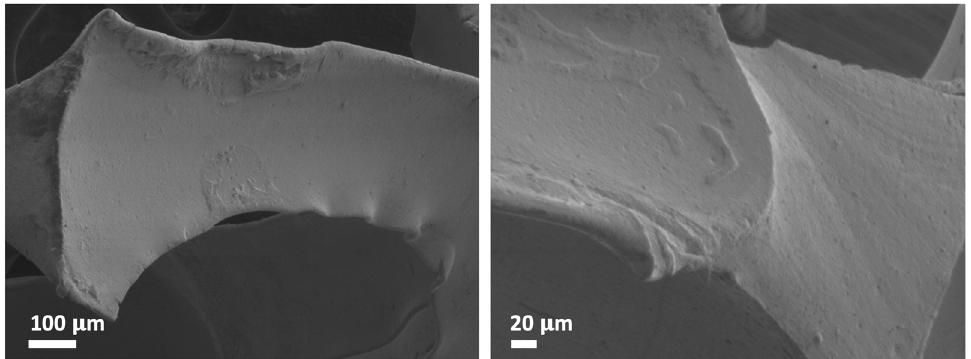
Figure 6. SEM images with different magnifications of spent EY-APTES@PDA@PUF after six cycles of 2-methyl-5-nitro-isoquinolin-2-ium iodide oxidation.